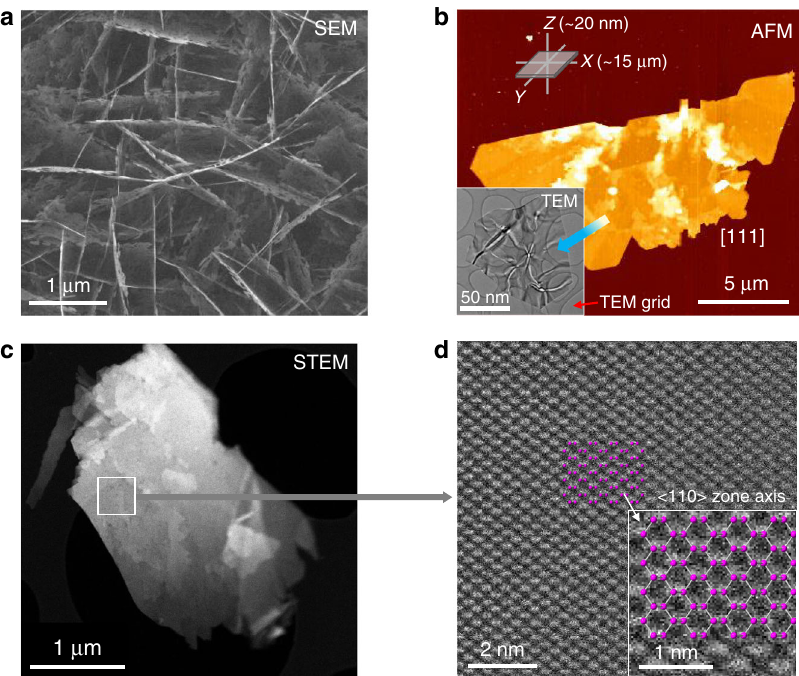
Fig. 1 Images of silicon nanosheets. a SEM image of a silicon nanosheet (Si-NS). b AFM, and TEM images of the silicon particle of [111] direction, about 20 nm thick. c , d STEM images of Si-NSs showing surfaces with silicon dumbbells along the <110> zone